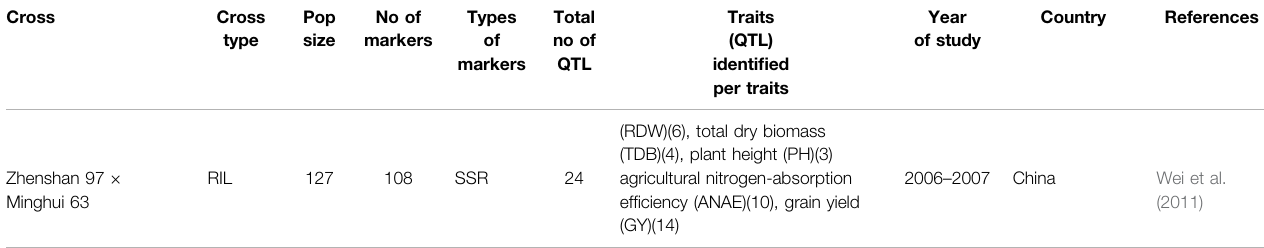
TABLE 1 | ( Continued ) Summary of the QTL studies used in the QTL meta-analysis for the nitrogen use ef fi ciency and related traits in rice. Cross